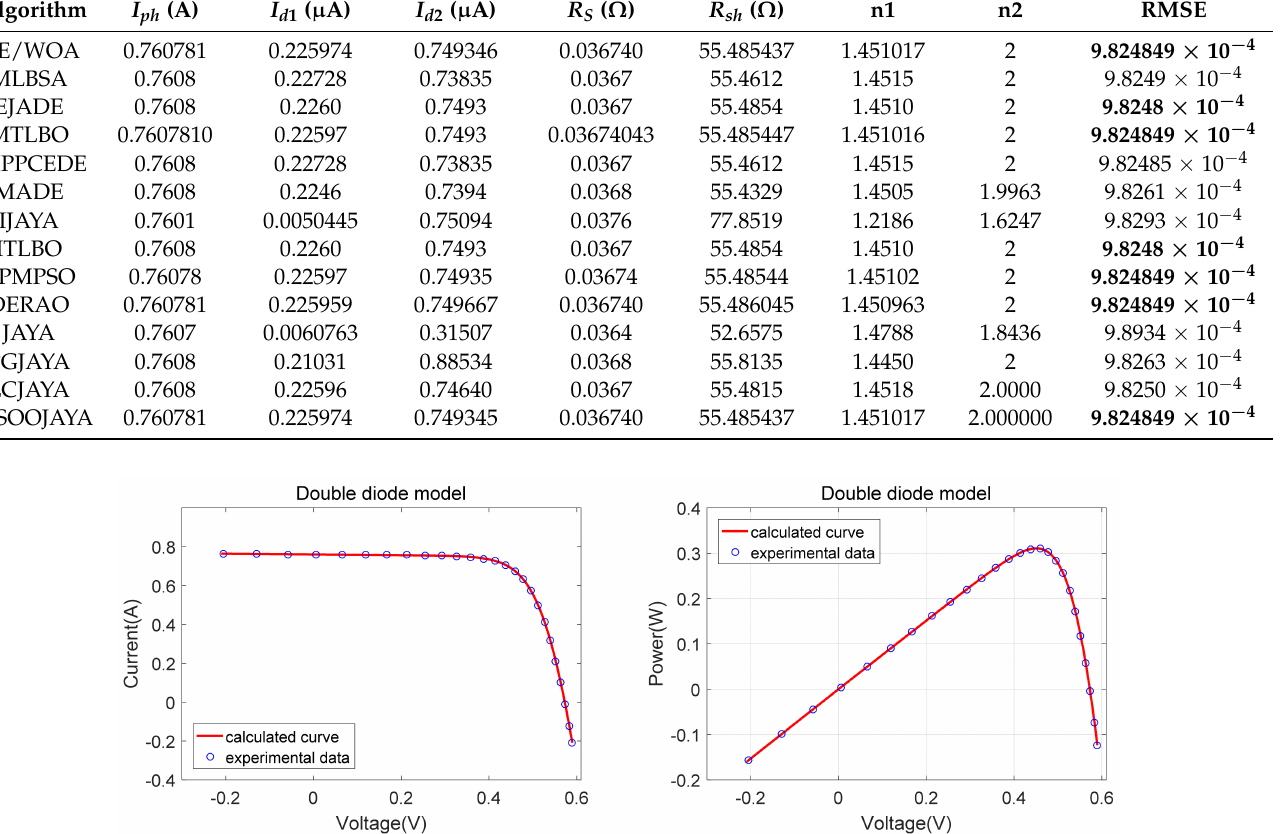
Figure 6. Experimental and calculated data of CSOOJAYA for